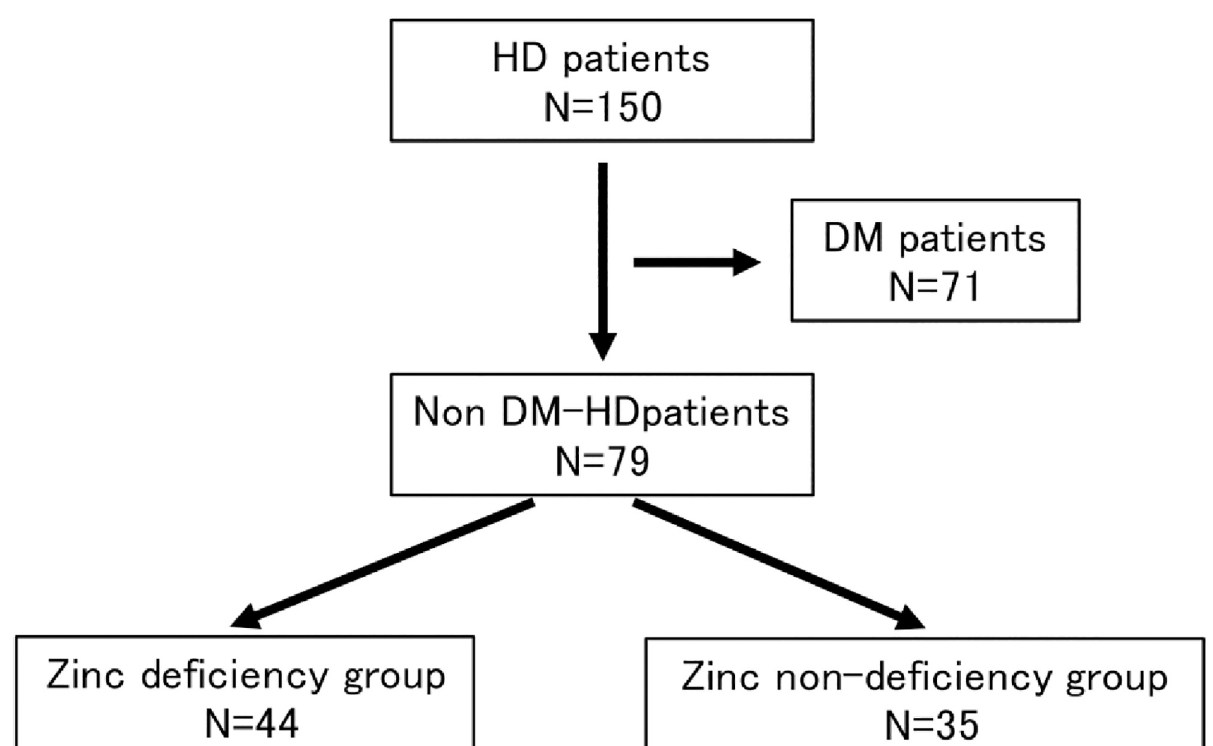
Fig 1. Classification between the zinc deficiency group and zinc non-deficiency groups. HD, hemodialysis; DM, diabetes mellitus.